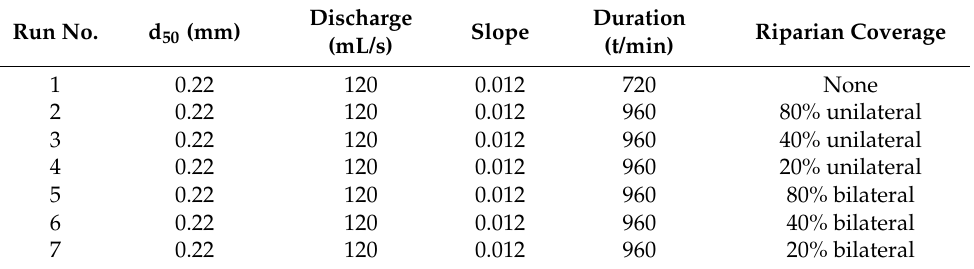
Table 1. Experiment cases.